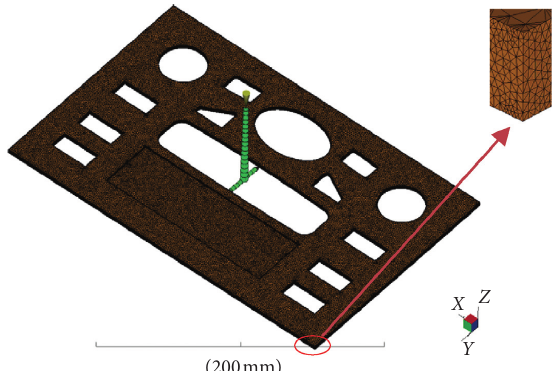
Figure 6: Schematic of the simulation